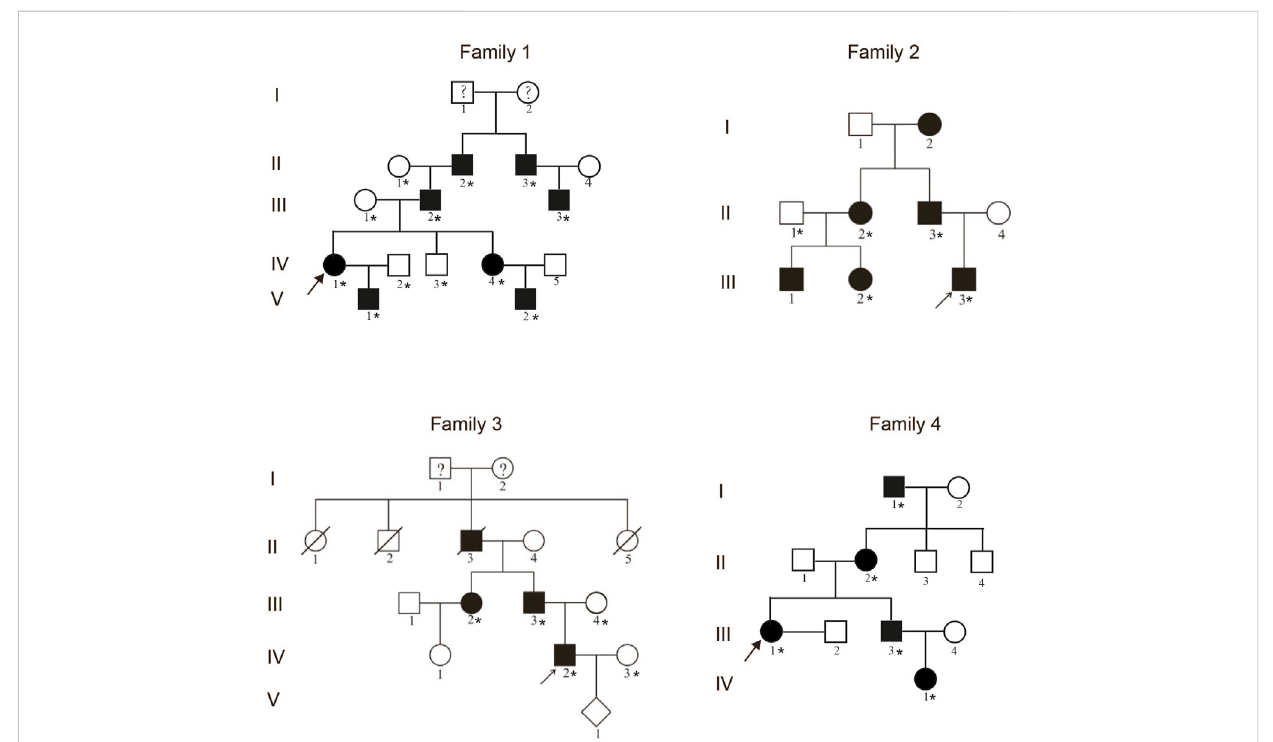
FIGURE 1 Pedigrees of four unrelated families with the synpolydactyly. The arrows indicate the proband. The asterisks represent the individuals in the families who provided peripheral blood